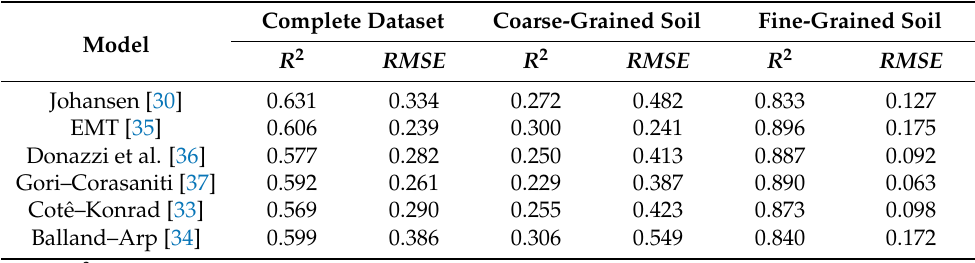
Table 5. Goodness-of-fit metrics of evaluated theoretical thermal conductivity models a . Model